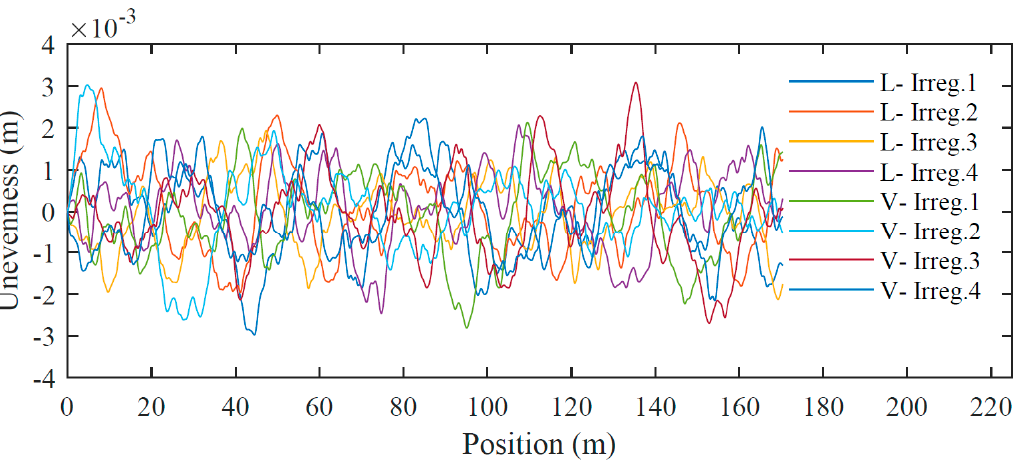
Figure 5. Track irregularity profiles.